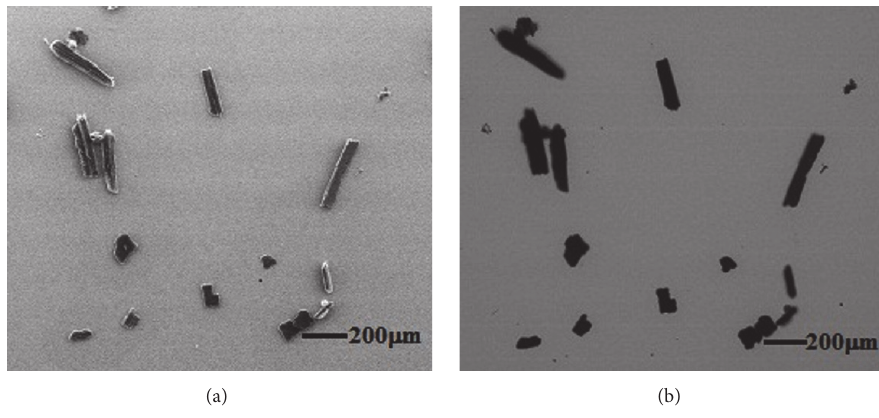
Figure 2: Particle images acquired by SEM: (a) SE image; (b) BSE